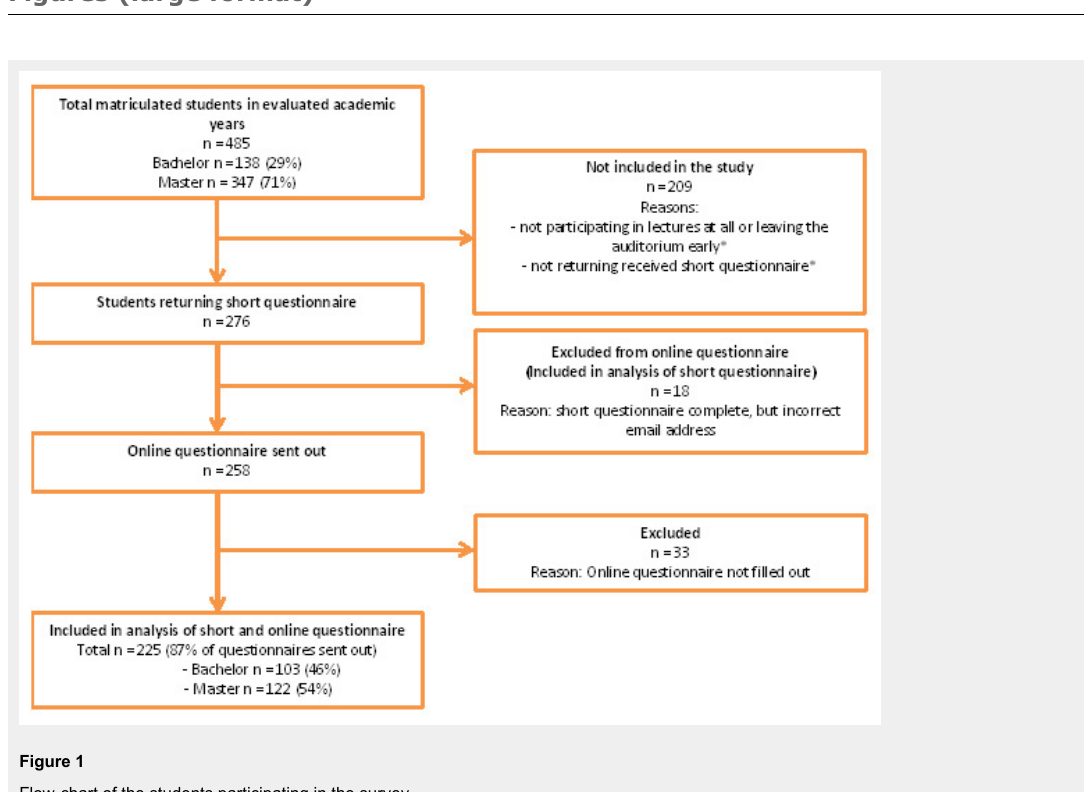
Figure 1 Flow-chart of the students participating in the survey. *Exact number of participating students (i.e., denominator) in lectures